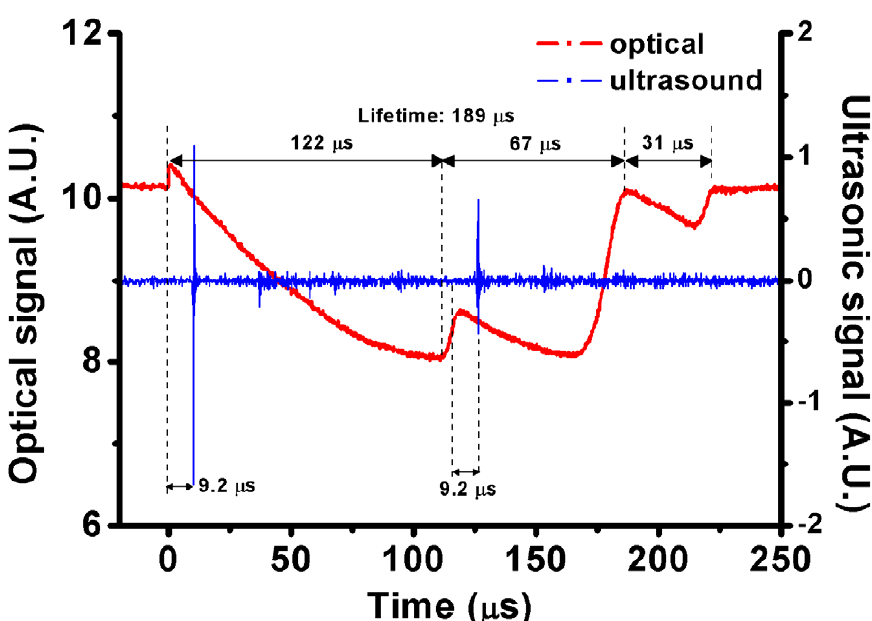
Figure 6. Optical (red) and photoacoustic (blue) signals of a typical coalesced microbubble of two or more microbubbles in 6 ppm GNR colloid with SPR of 966 nm induced by a 980 nm pulsed laser of 8.54 mJ energy. The lifetimes of the coalescence and re-bound cycles of microbubble are 189 and 31 µ s, respectively. The coalescence induces a shockwave detected by UT.